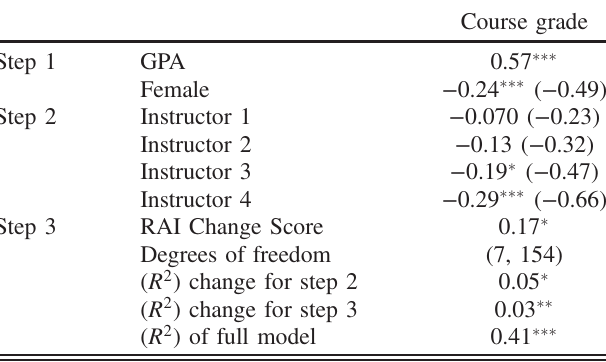
TABLE VII. Regression testing for the dependence of Course Grade on change over the quarter in relative autonomous reasons for studying physics (RAI Change Score), after controlling for GPA and Female (step 1) and instructor variables (step 2). Standardized correlation coefficients ( β ’ s) are given with accom- panying p values, where (cid:2) p < 0 . 05 , (cid:2)(cid:2) p < 0 . 01 , (cid:2)(cid:2)(cid:2) p < 0 . 001 . For the dummy independent variables (Female and the instructor variables), the coefficients when only the dependent variables ’ s) are given in parenthesis. The degrees were standardized ( β DV of freedom, R 2 changes, and R 2 of the full model are also